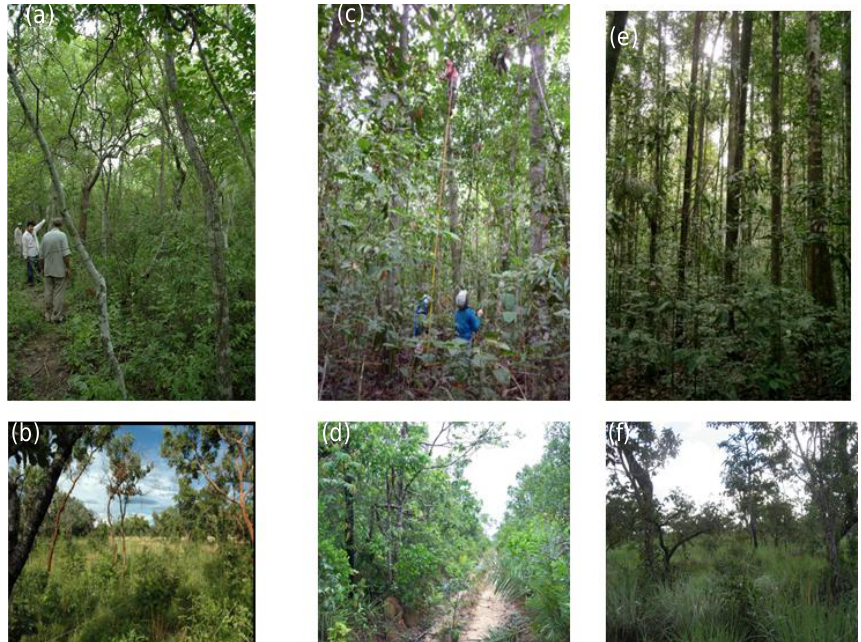
Figure 2. Examples of forest (top row) and savanna (bottom row) vegetation formation types found along the precipitation gradient. (a) TUC- 01 forest, (b) TUC-03 savanna (both towards the drier end of the transect); (c) FLO-01 forest, (d) SMT-02 savanna (both in the middle of the Transect); (e) TAP-123 forest (f) ALC-02 savanna (both at the moister end of the transect). Specific details of site locations, climatology and soils are given in Fig. 1 and Table S1 of the